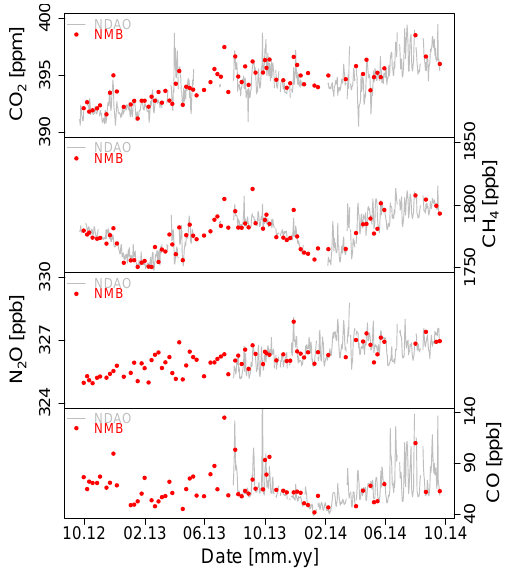
Figure 10. NDAO in situ measurements compared to NMB (NOAA) flask measurements. NDAO values are hourly averages matching the NOAA time of sampling (grey line), NMB values are averages of flask pairs (red circles). Flagged values from the NOAA data set have been excluded, but preliminary data are